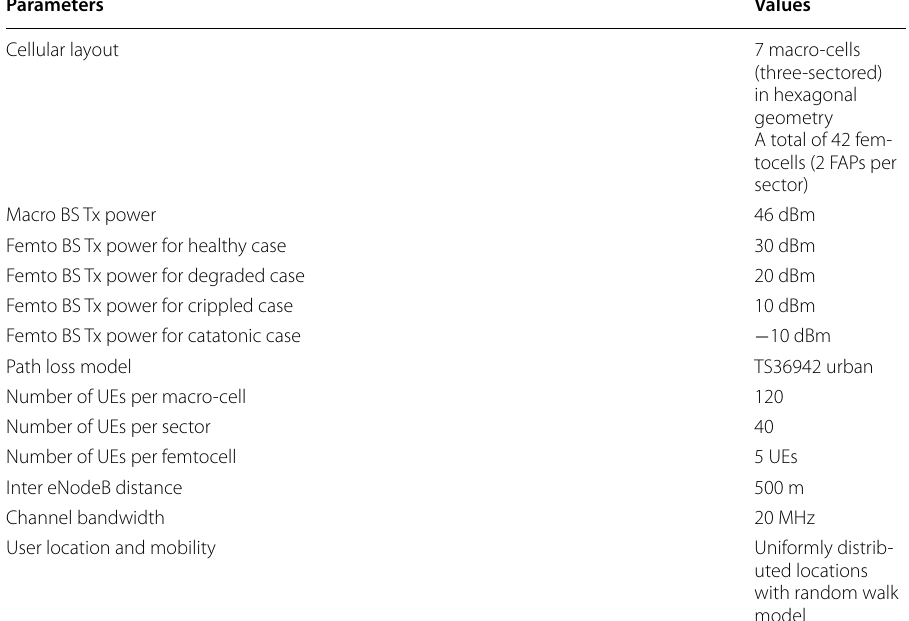
Table 1 RAN simulation parameters